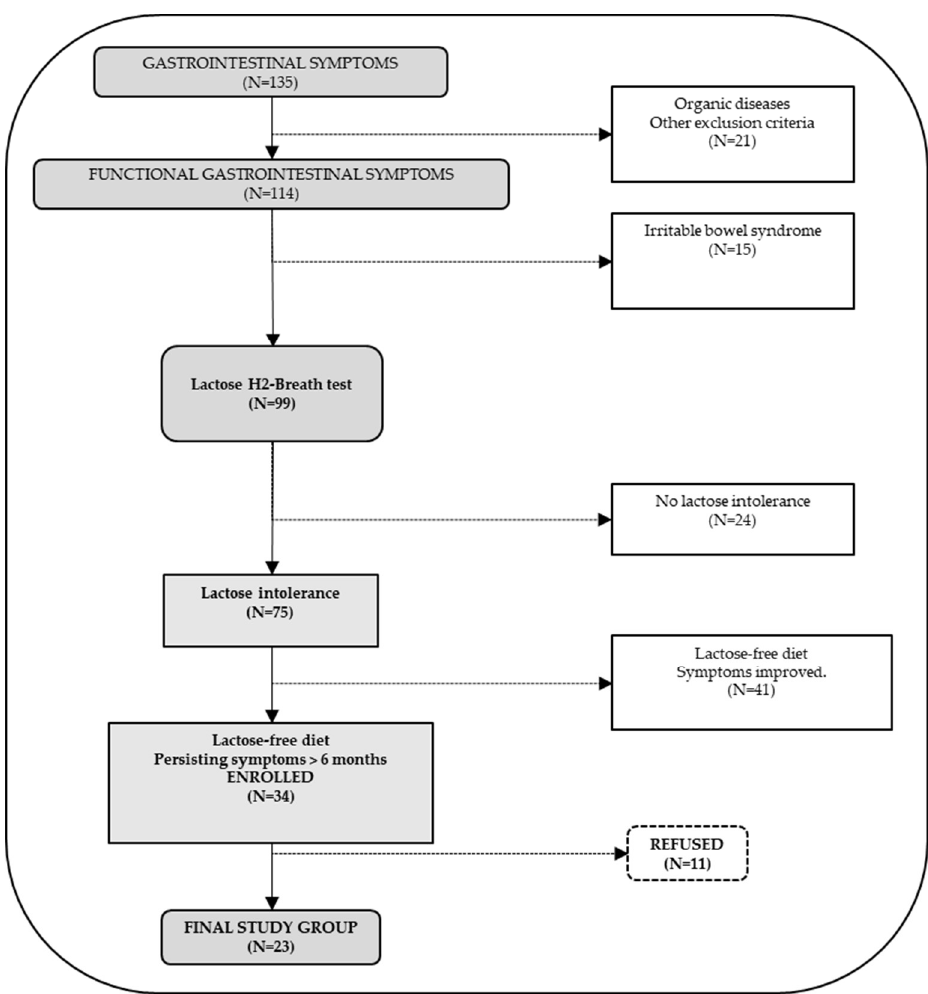
Figure 1. Consort flow-chart of screened patients. Starting from a general group of 135 symptomatic patients, and after exclusion of 21 patients with organic diseases, a subgroup of 114 patients had functional gastrointestinal symptoms. After further exclusions of 15 patients with Rome IV criteria, 99 patients underwent lactose H2 breath test and 75 were lactose intolerant, of which 34 had persisting symptoms following a lactose-free diet for at least six months, and were enrolled. Following the refusal of 11 subjects, the final study group consisted of 23